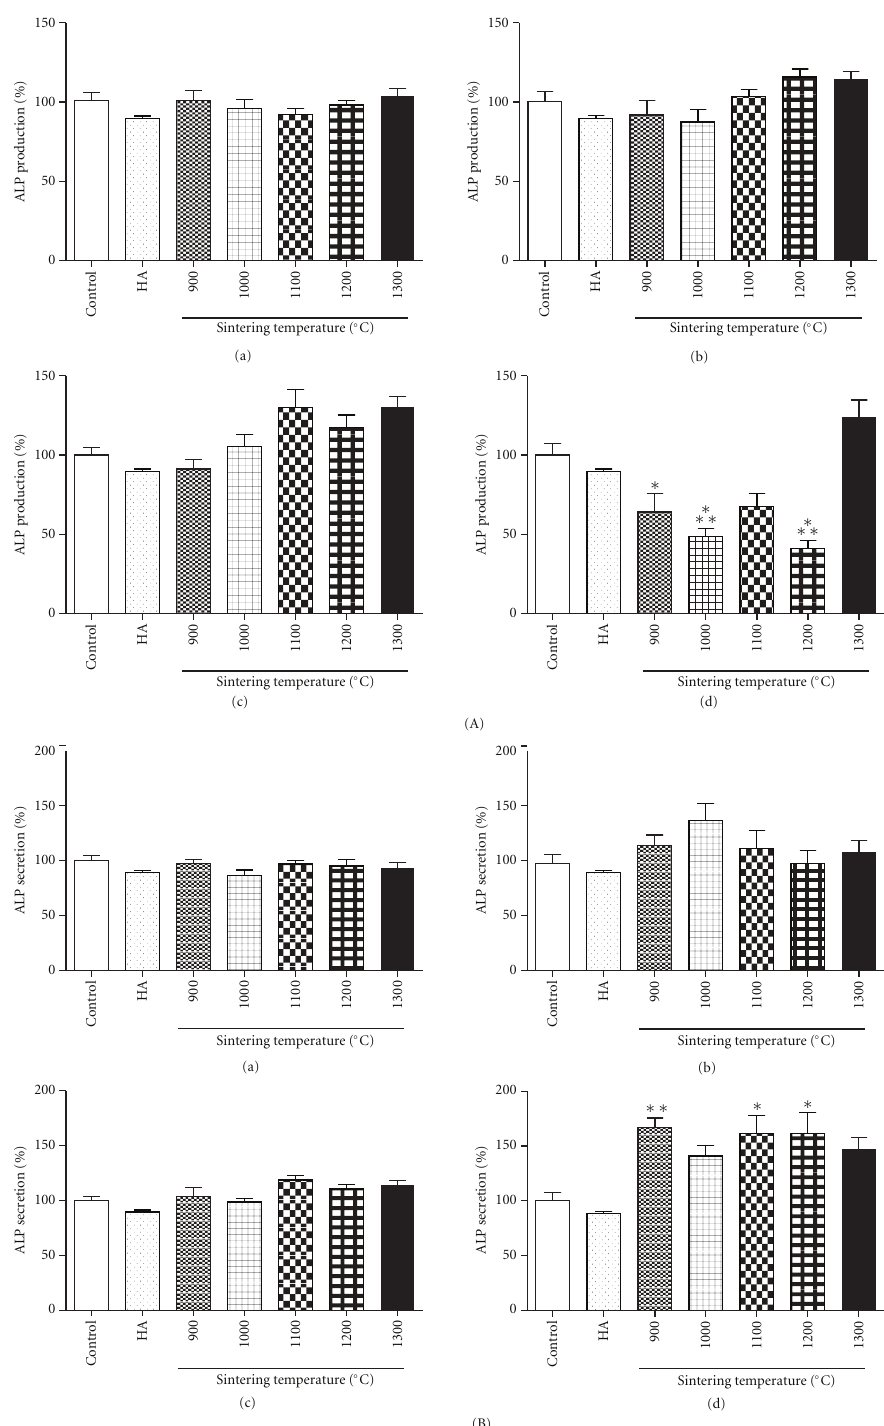
Figure 2: Alkaline Phosphatase (ALP) production of osteoblasts cultured in the presence of di ff erent concentrations of LiHA. Panel (A): ALP production measured inside the cells. (a) 0.25% LiHA, (b) 0.50% LiHA, (c) 1.0% LiHA, and (d) 2.0% LiHA. Panel (B): ALP secretion measured from culture supernatant. (a) 0.25% LiHA, (b) 0.50% LiHA, (c) 1.0% LiHA, and (d) 2.0% LiHA. The results are expressed as the means ± SD, ( ∗ ) indicating a significant di ff erence comparing to control with P < 0 .